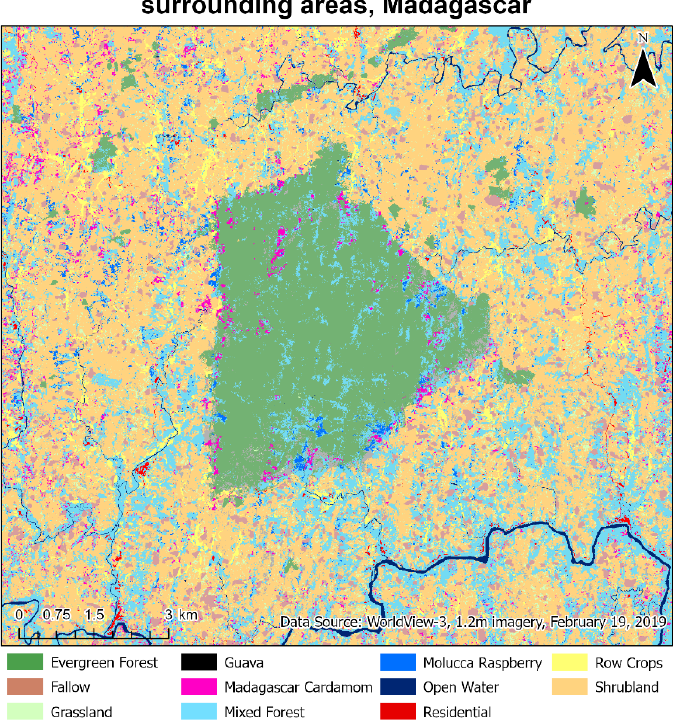
Figure 8. Detailed and highly accurate classification map of the BNR and surrounding areas, created using WorldView-3 imagery and post-classification editing, showing the distribution of 11 classes. Table 4. Percentage and area in hectares of each class type mapped in 2019 within the study area, based on the classification map seen in Figure